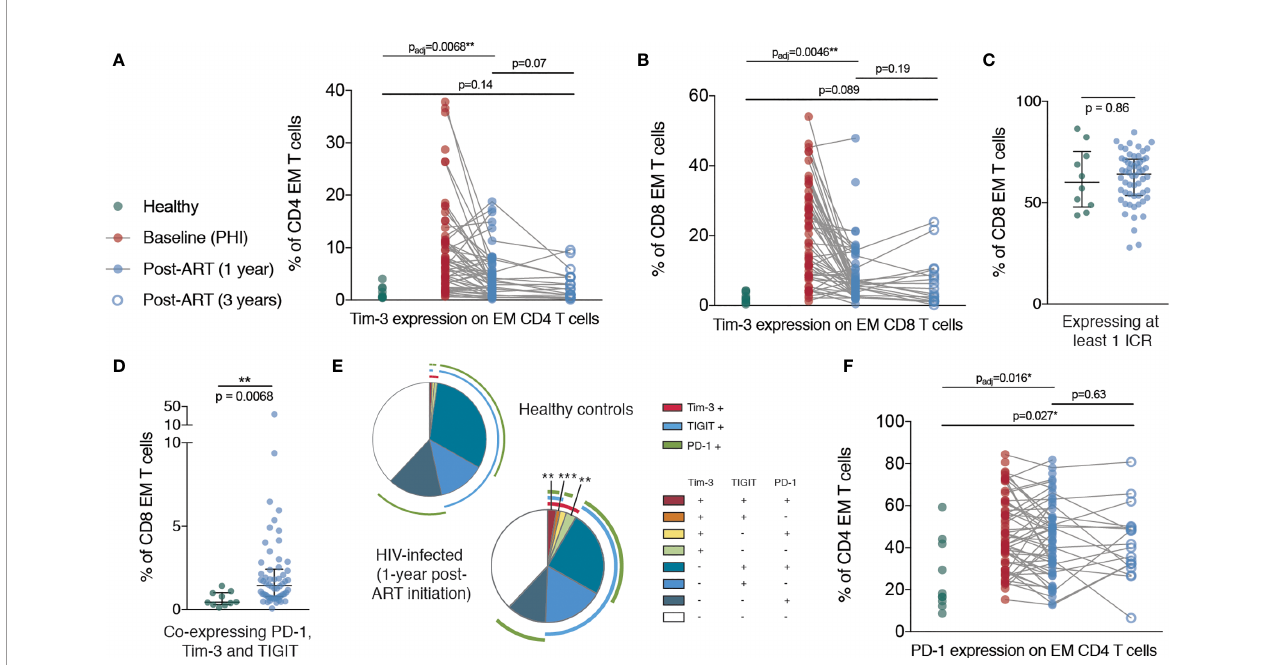
FIGURE 4 | Persistent elevation of Tim-3 and PD-1 on memory T cells despite ART initiation during PHI. (A) Tim-3 expression on EM CD4 T cells are shown for healthy controls (n = 10, green), during PHI (n = 60, red), following 1 year of ART (n = 58, blue closed circles) and 3 years of ART (n = 18, blue open circles). (B) Tim-3 expression on EM CD8 T cells. The percentage of CD8 EM cells which express at least 1 ICR (PD-1 or Tim-3 or TIGIT) (C) or all three ICRs (D) was compared between healthy controls (green) and 1 year ART-treated individuals (blue). (E) Co-expression of ICRs on CD8 EM cells in healthy controls following 1 year of ART. Each segment represents the proportion of cells (median) with a different co-expression combination; arcs indicate which markers are in that combination. Co-expressing combinations (on all CD4 and CD8 memory subsets) were compared between healthy controls and ART treated individuals using a Mann-Whitney test; p-values were adjusted to control the false-discovery rate. Segments marked with an asterisk are signi fi cantly different between healthy controls and ART- treated individuals. (F) PD-1 expression on CD4 EM T cells. For (A, B, F) Comparisons between healthy controls and 1 year values were performed as in Figure 3B (asterisks and listed p-values correspond to the adjusted p-value); additional tests involving 3 year timepoint are only shown for groups for which p < 0.05 as in Figure 3B . Other groups were compared using Mann-Whitney tests (unadjusted); the PHI group is shown as a visual aid and was not included in formal comparisons. Asterisks and listed p-values correspond to the adjusted p-value. * indicates p < 0.05; ** indicates p < 0.01; *** indicates p <